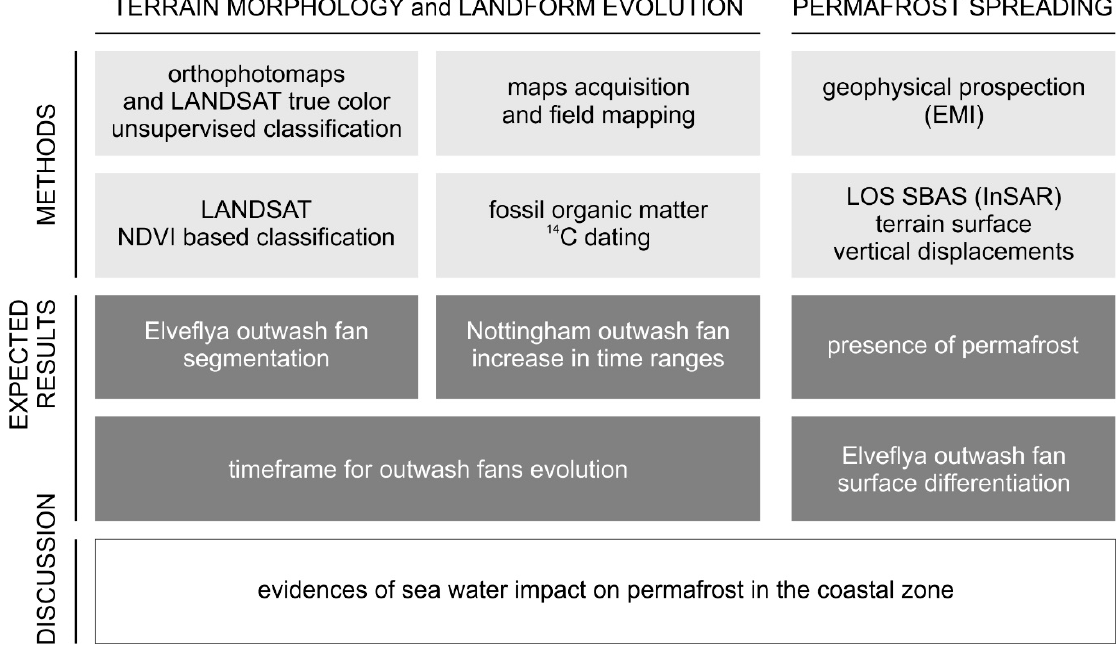
Figure 1. A simplified investigation scheme presented in a block diagram. Table 1. Summary of the remote sensing data.